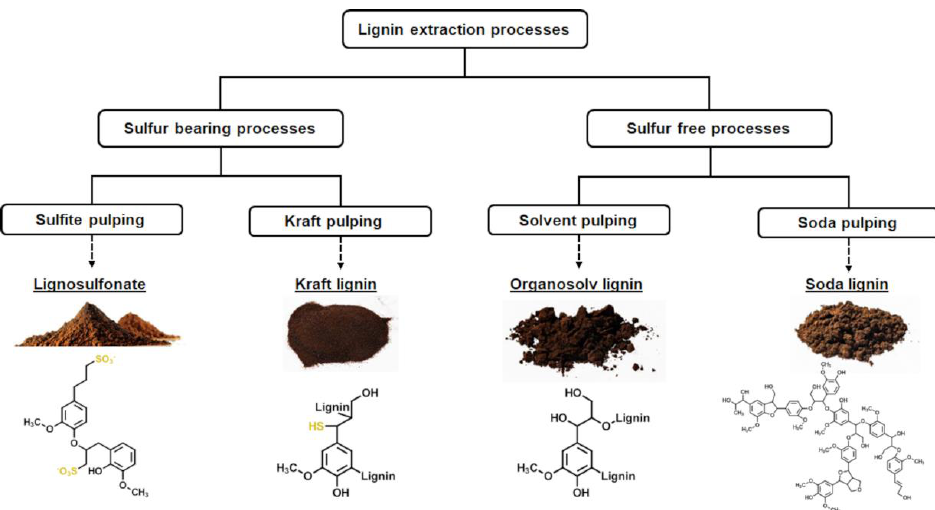
Figure 2. Overview of the most common lignin extraction processes and representative structures of the generated technical